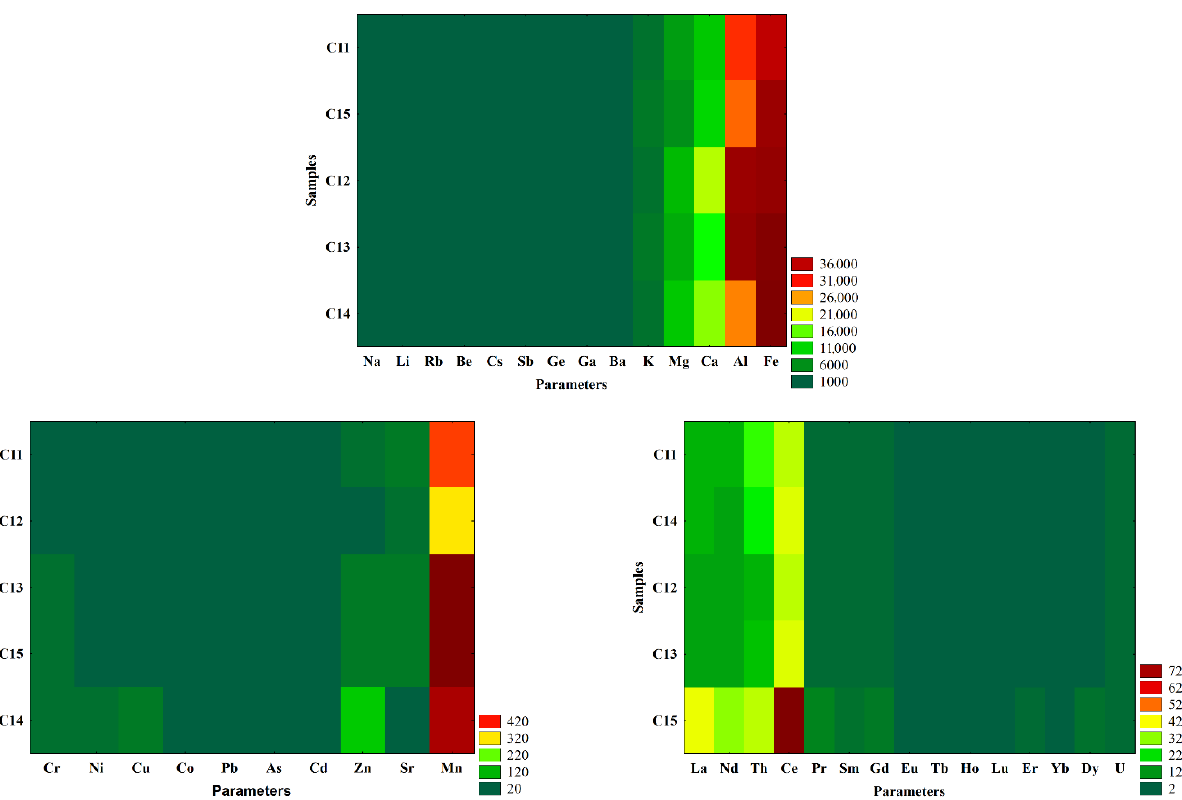
Figure 7. Heat maps after the two-way joining analysis as a clustering method to emphasize the variations of the elemental characteristics in the silty soil samples collected from Clo ș ani Cave. The measurement units of the parameters are presented in Table 3.